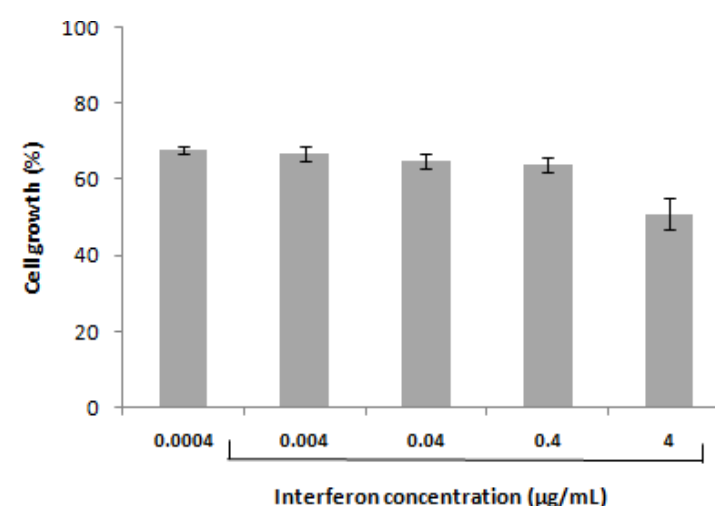
Figure 4. MCF-7 cell line growth inhibition by rhIFNα-2b (P <0.0001).